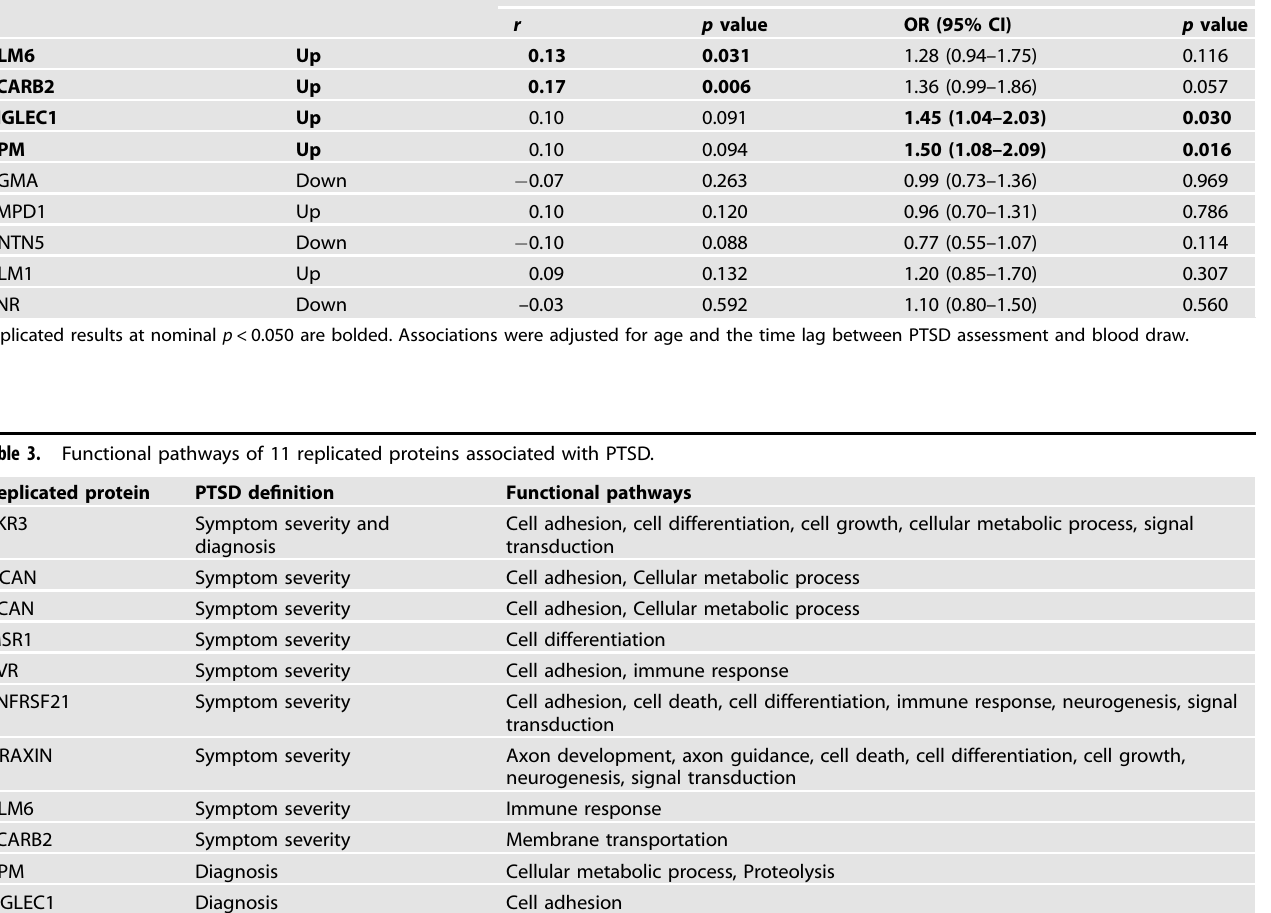
PTSD symptom severity, as well as diagnostic status, in a hold-out sample. Together, the current fi ndings make an important contribution to the understanding of the pattern of differential protein expression characterizing PTSD. If generalizable to other populations, they may aid in the development of biomarkers for detecting and monitoring PTSD. The current study replicated fi ndings for seven differentially expressed proteins that were originally discovered by Kuan et al. (2020). Most notably, serine/threonine-protein kinase receptor R3 (SKR3) was associated with both dimensional PTSD symptom severity and PTSD diagnosis in the current sample. SKR3 is expressed in neurons and regulates normal blood vessel development. The remaining six proteins replicated only in association with dimensional PTSD symptom severity. Neurocan (NCAN) and brevican (BCAN) were found to be downregulated in patients with higher PTSD symptom severity. NCAN is thought to be emerged as genome-wide-signi fi cant risk loci for bipolar disorder